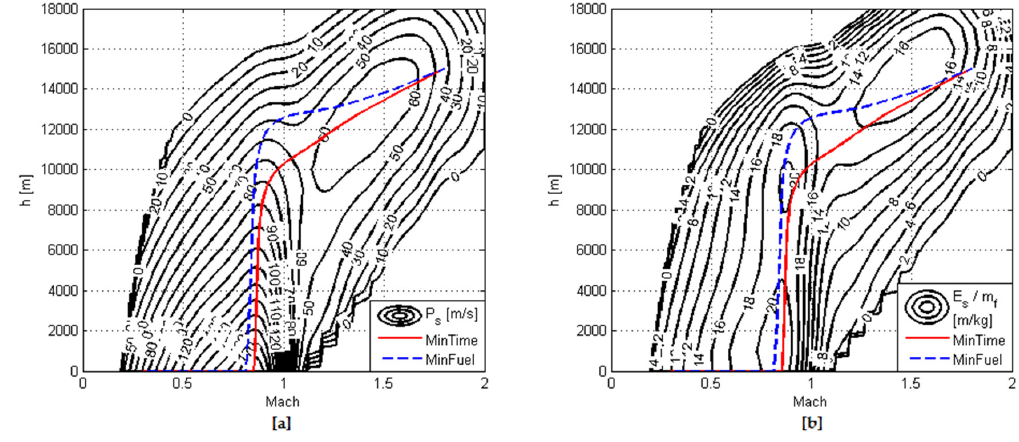
Figure 18. Case B, Configuration C2; Minimum Time and Minimum Fuel climb paths, plotted over contours of: Specific Excess Power (m/s) ( a ); and Energy Efficiency (m/kg) ( b ).